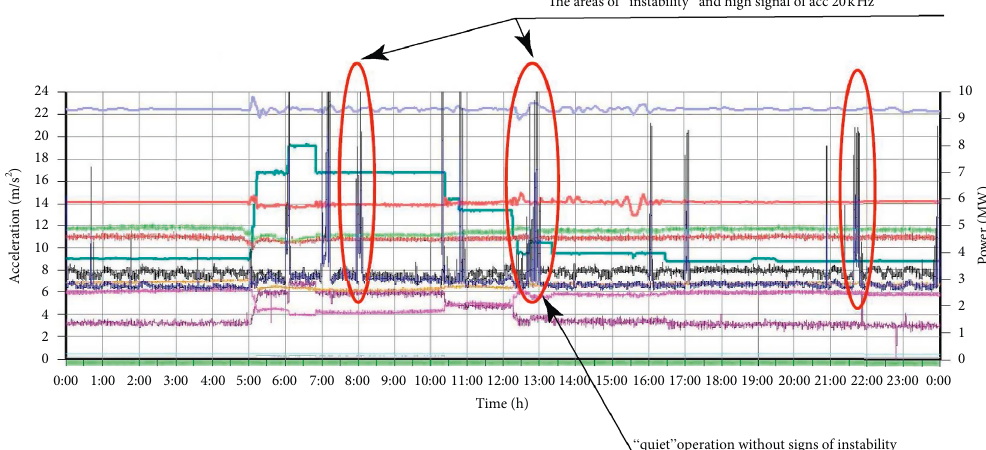
Figure 3: The areas of “instability” and high signal of acc 20kHz and “quiet” operation without signs of instability.